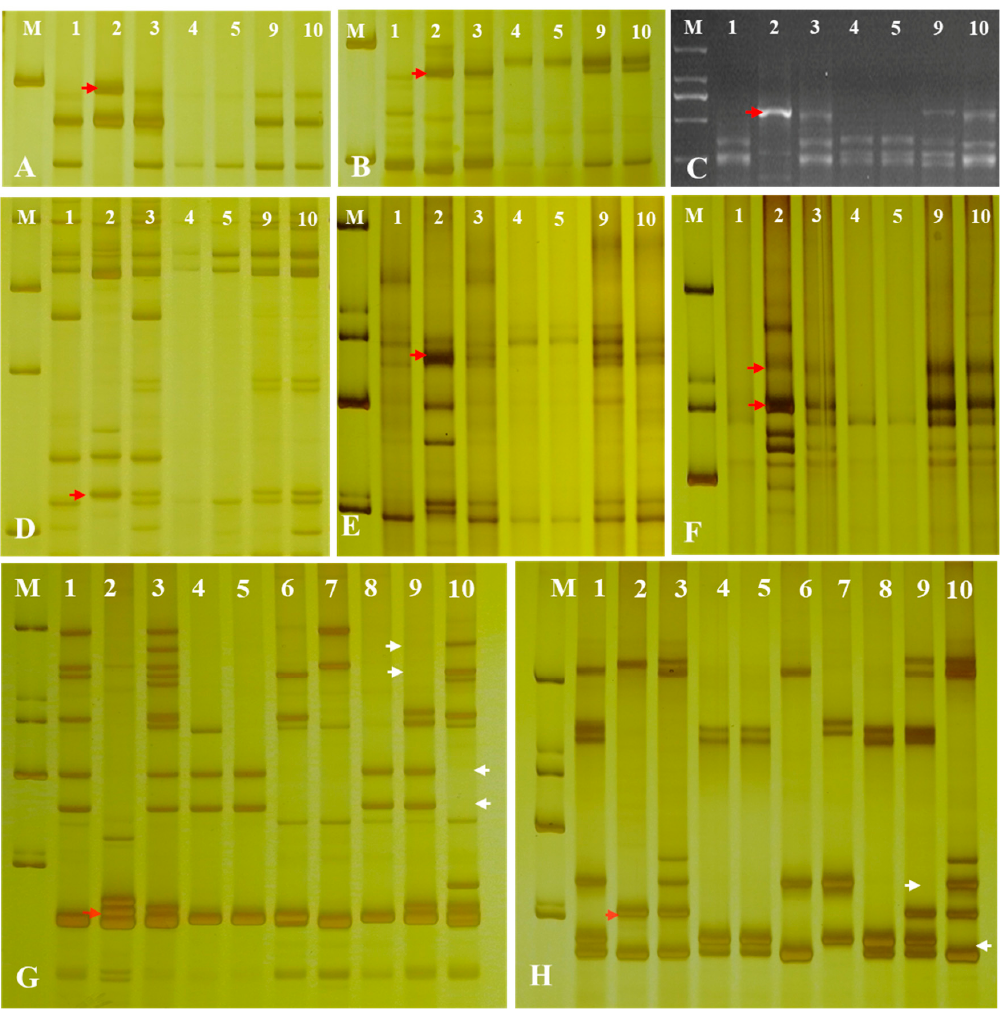
Figure 4. Molecular markers analysis of W623 and W637. M, marker; 1, Triticum aestivum cv. Chinese Spring; 2, Ae. geniculata ; 3, W166; 4, Abbondanza nullisomic line 7A; Lane 5, Abbondanza nullisomic line 7B; 6, CSN7AT7D; 7, CSN7DT7B; 8, CSN7BT7A; 9, W623; 10, W637; ( A ) TANC1782-Taq I . ( B ) TANC1845-Taq I . ( C ) TANC1811- Hae Ⅲ . ( D ) TANC1888- Hae Ⅲ . ( E ) TANC1929-Taq I . ( F ) TANC1929- Hae Ⅲ . ( G ) BE426692 . ( H ) BE637663 . The red arrow indicated an Ae. geniculata -specific bands and the white arrow directed CS and the nulli-tetrasomic specific bands.